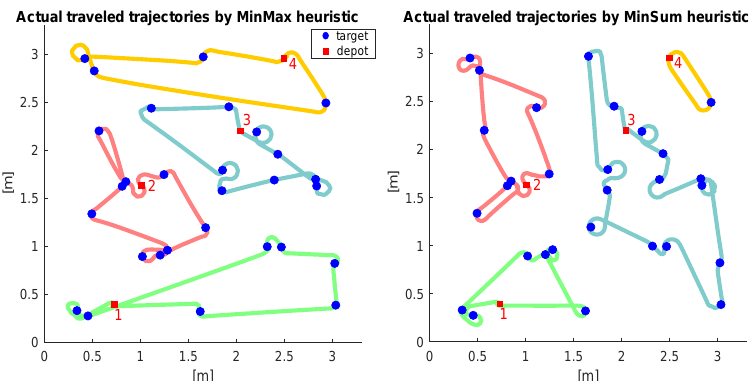
Figure 5. The resultant trajectories of the robots with the proposed algorithm ( left ) and min-sum heuristic ( right ) for an instance with 4 robots and 29 targets. The numbers next to the depots represent the index of the robots. The green, red, blue, and yellow paths represent the trajectories for robots 1, 2, 3, and 4,